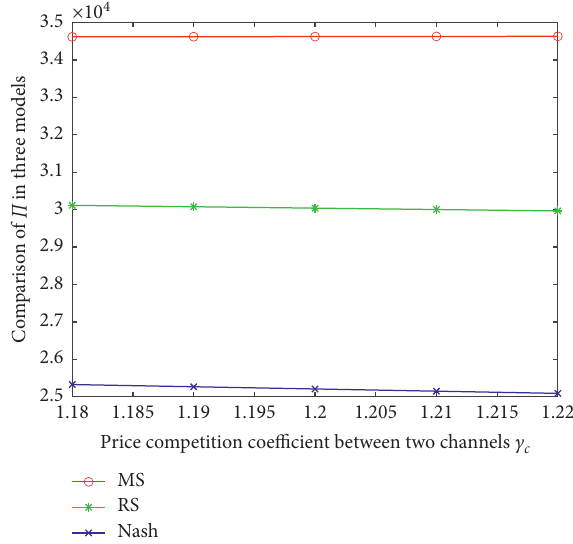
Figure 14: The comparison of the overall supply chain’s profit Π in the three models.